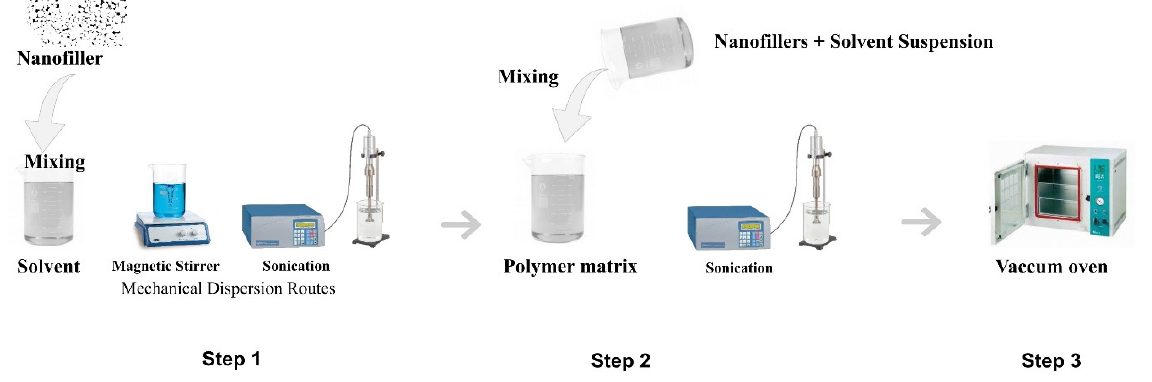
Figure 1. Preparation route for nanocomposite resin.